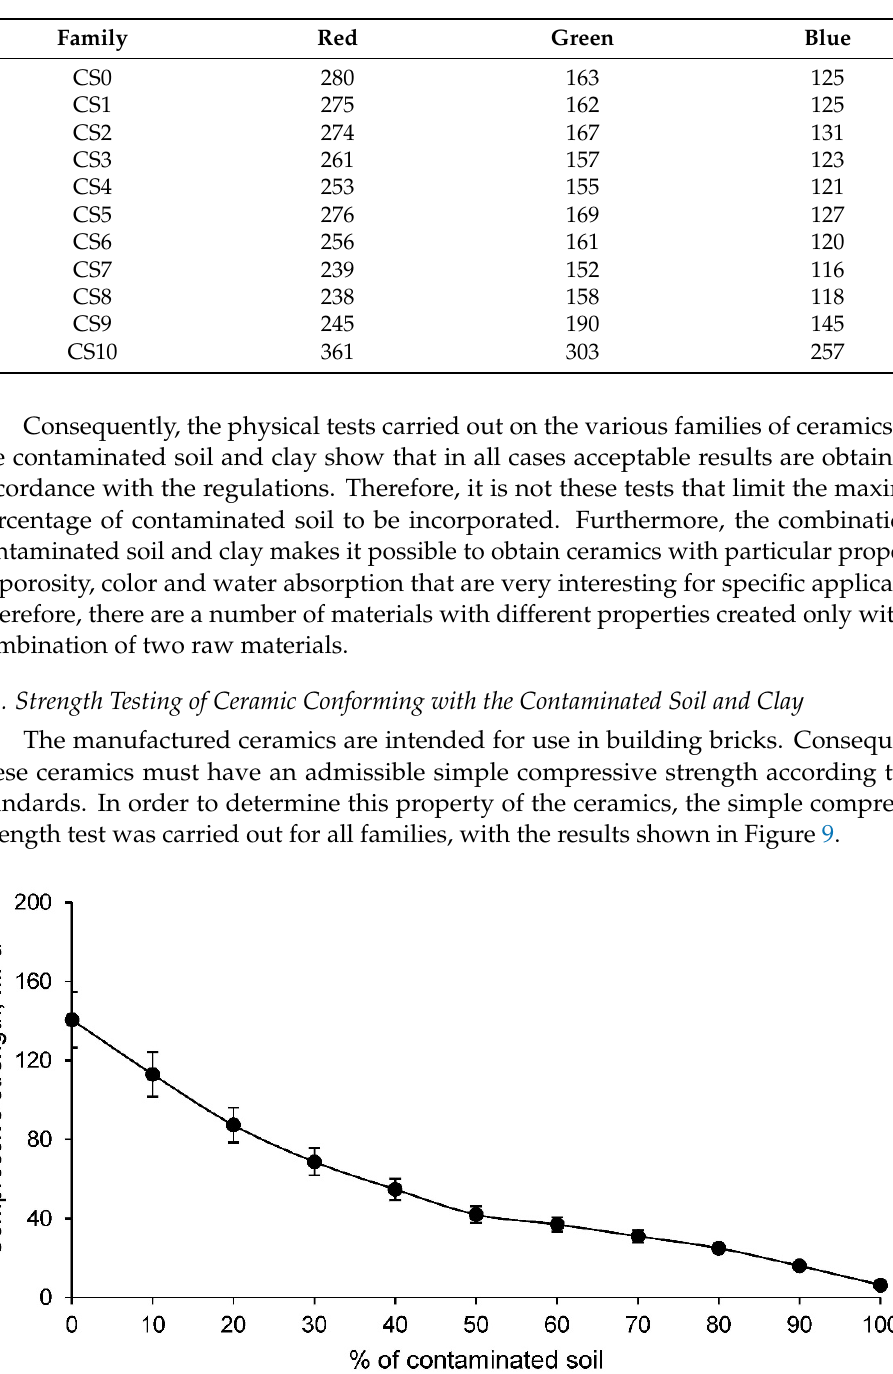
Figure 9. Simple compressive strength of families of ceramics conformed with various percentages of clay and contaminated soil.